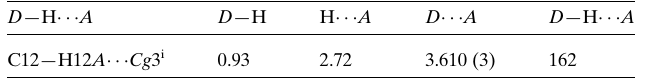
Table 1 C—H (cid:2)(cid:2)(cid:2) (cid:2) interactions (A˚ , (cid:3) ). Cg 3 is the centroid of the C17–C22 ring.